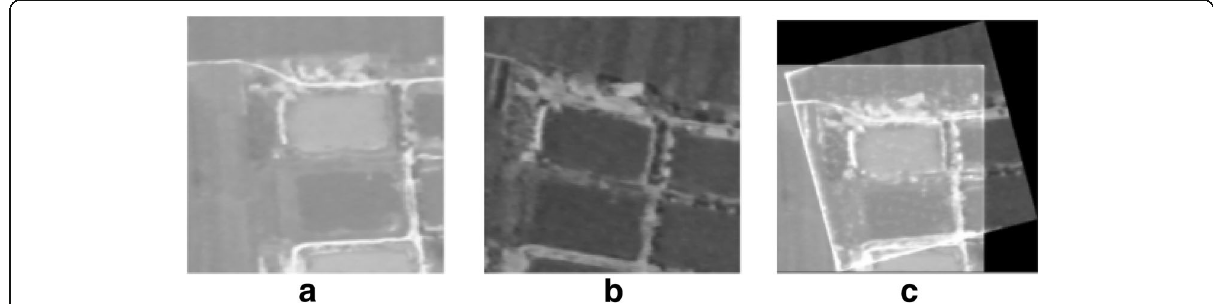
Fig. 5 One of the image registration in video one. a Visible light image. b Infrared image. c Registration